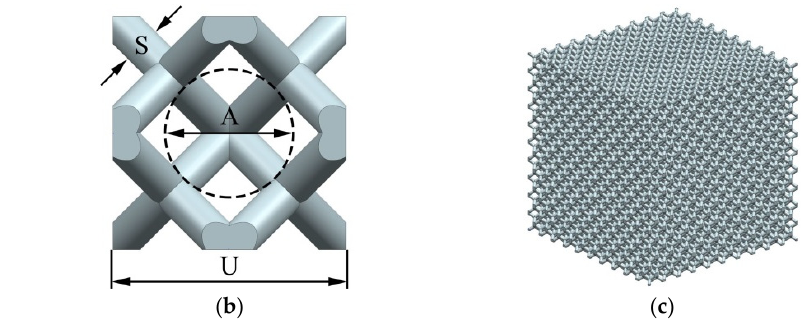
Figure 3. Rhombic dodecahedron porous structure: ( a ) geometry; ( b ) geometric parameters; ( c ) spec- imen model. Table 2. Geometric parameters of the rhombic dodecahedron porous structure.